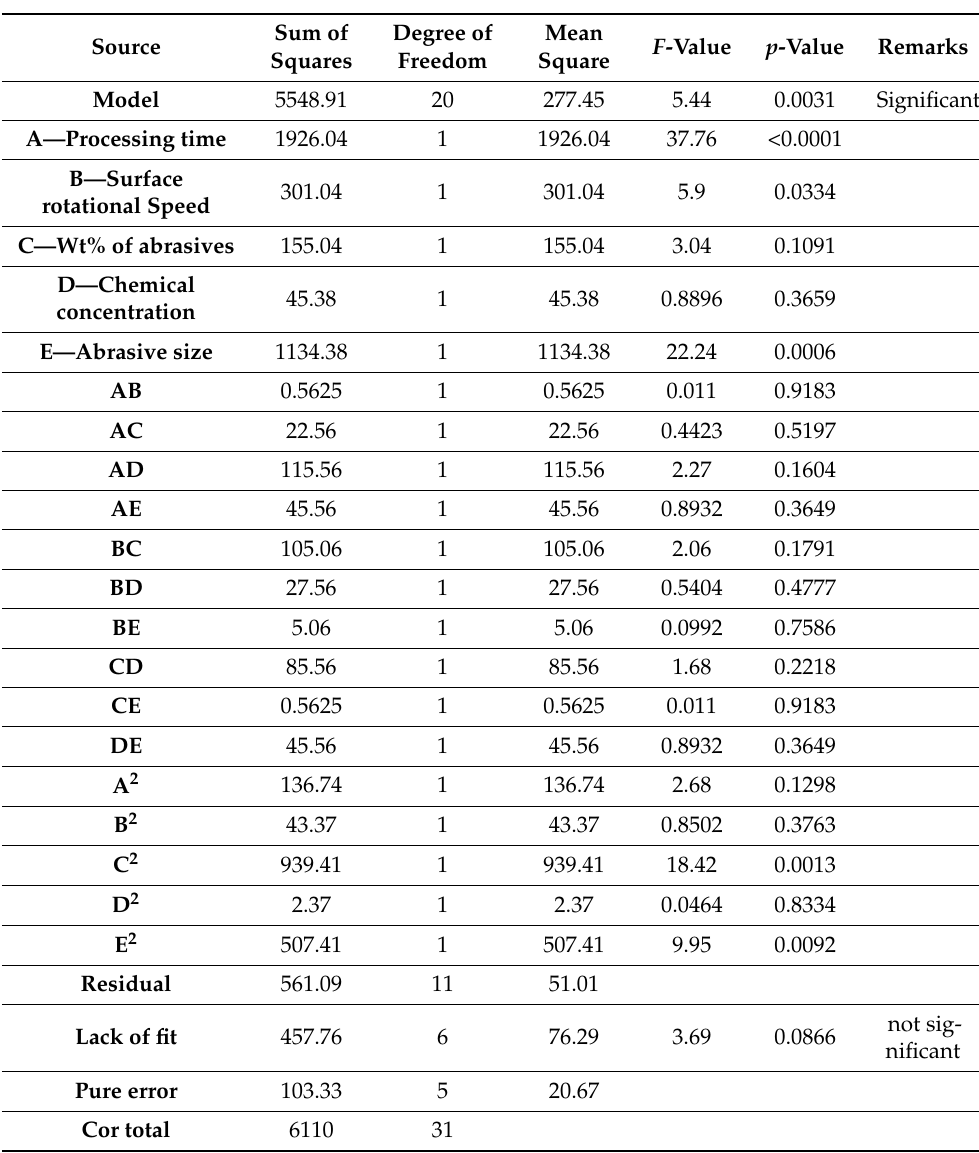
Table 3. ANOVA for